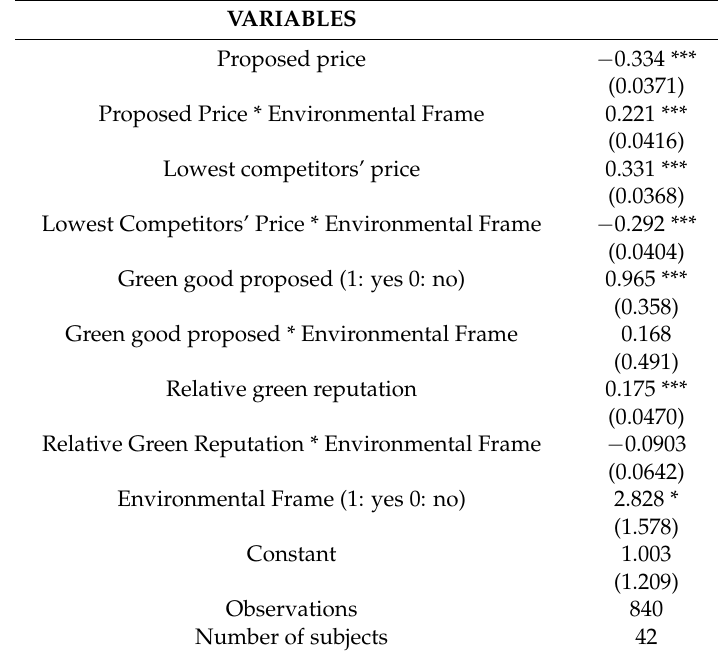
Table 6. Panel data Logit model for the probability of seller selling at least one